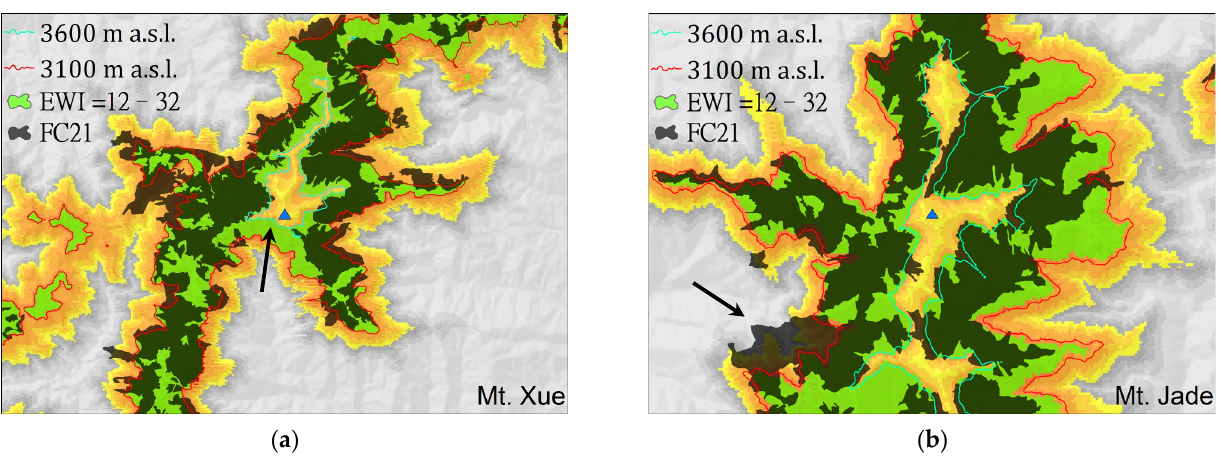
Figure 3. Predictive distribution of Abies kawakamii , using EWI = 12–32 (green polygon), overlapping its actual (FC21, block polygon) and potential (occurrence probability, orange tone) distribution. ( a ) Mt. Xue and ( b ) Mt. Jade.